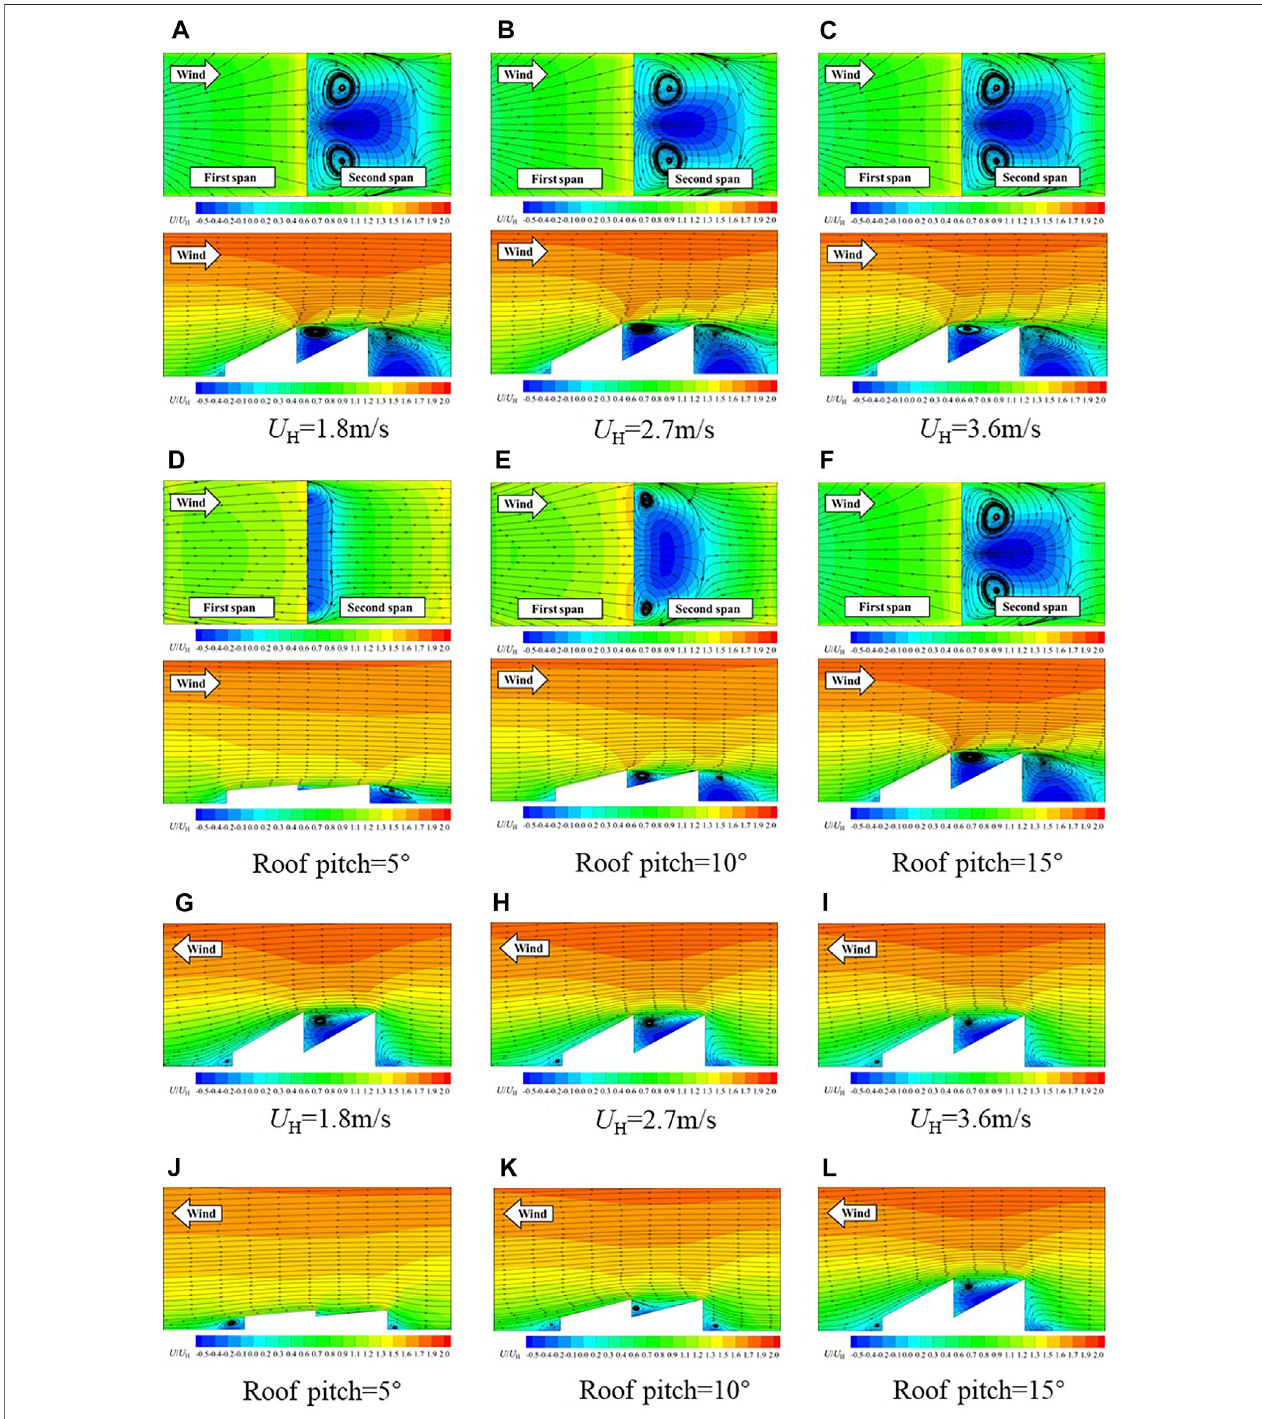
FIGURE 15 | Contours of dimensionless wind velocity simulated by CFD. (A-F) positive wind direction and (G-L) negative wind direction.